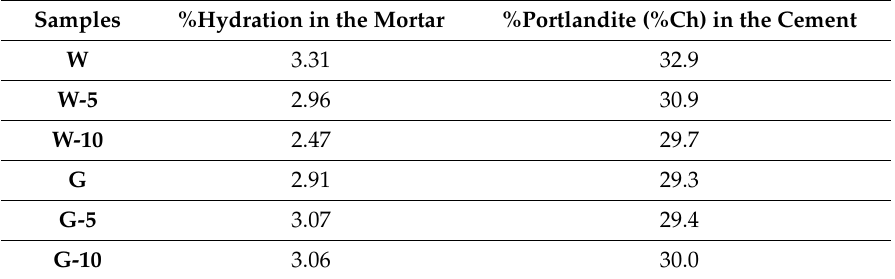
Table 3. Percentages of hydration and portlandite in the studied